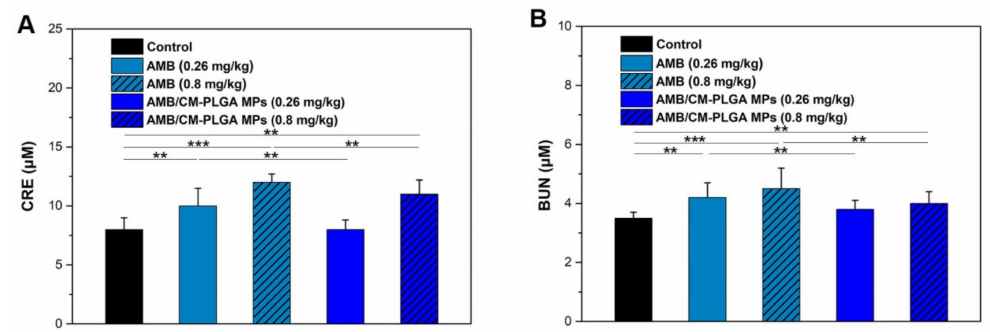
Figure 4. In vivo nephrotoxicity assay. CRE ( A ) and BUN ( B ) in plasma after treatment of AMB (0.26 or 0.8 mg/kg) and AMB/CM-PLGA MPs (0.26 or 0.8 mg/kg), respectively. ** p < 0.05. *** p < 0.01.